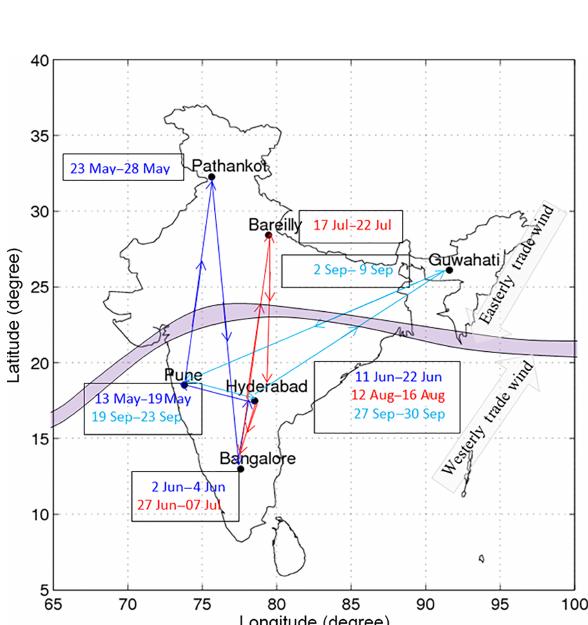
Figure 1. Map showing high-resolution GPS radiosonde launchings in three rounds during May–September 2009 over the Indian mon- soon region. The first round (blue), second round (red), and third round (cyan) were conducted during May–June, July–August, and September,